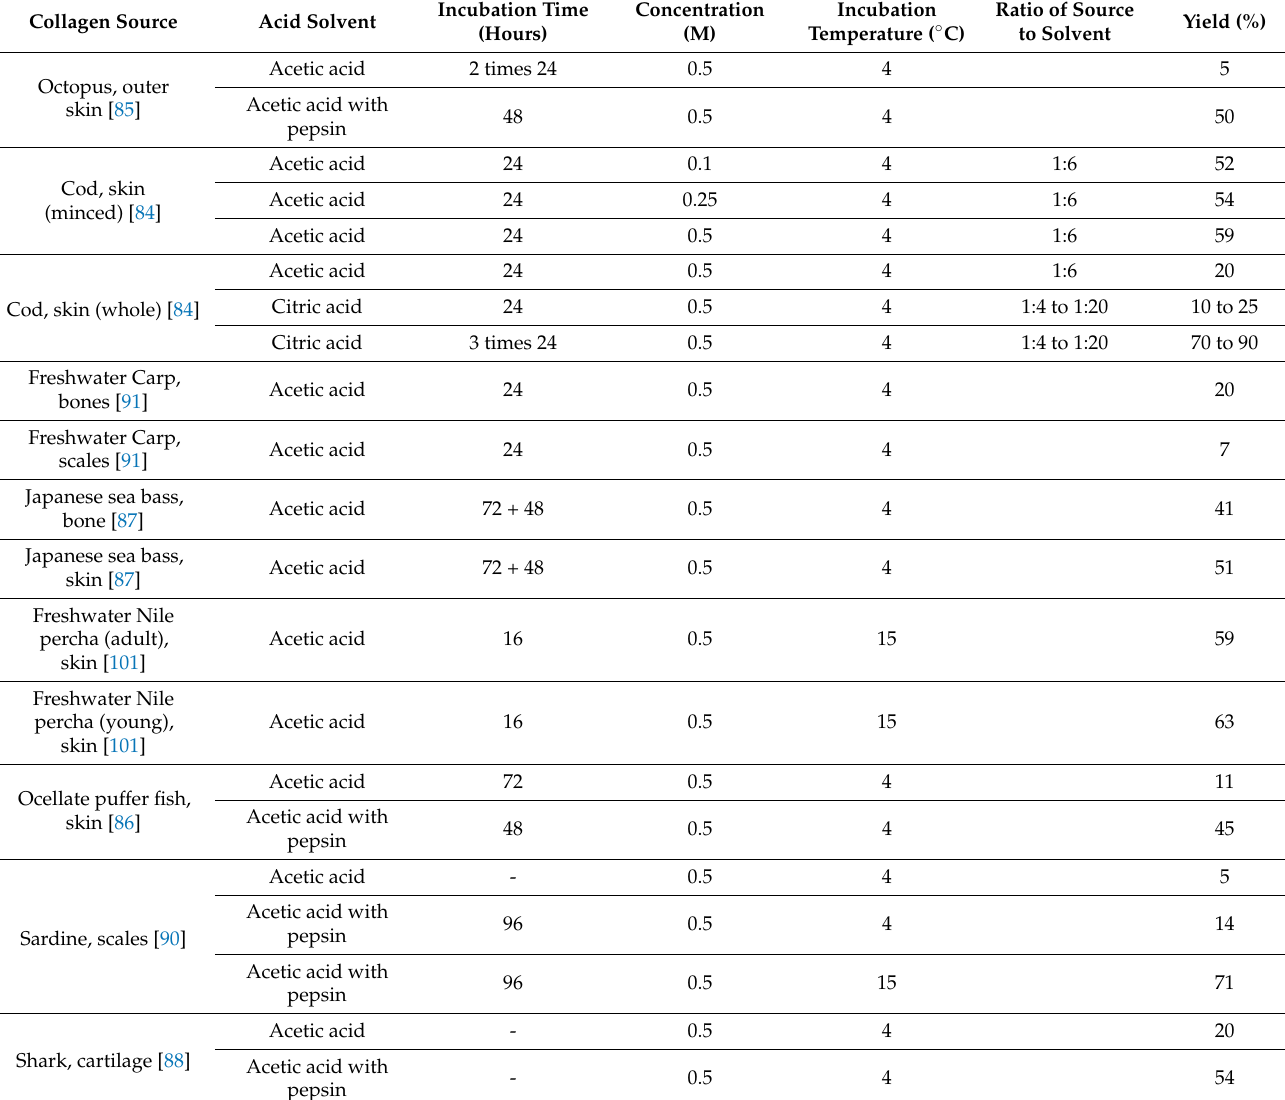
Table 4. Acid- and enzyme-based hydrolysis with common process